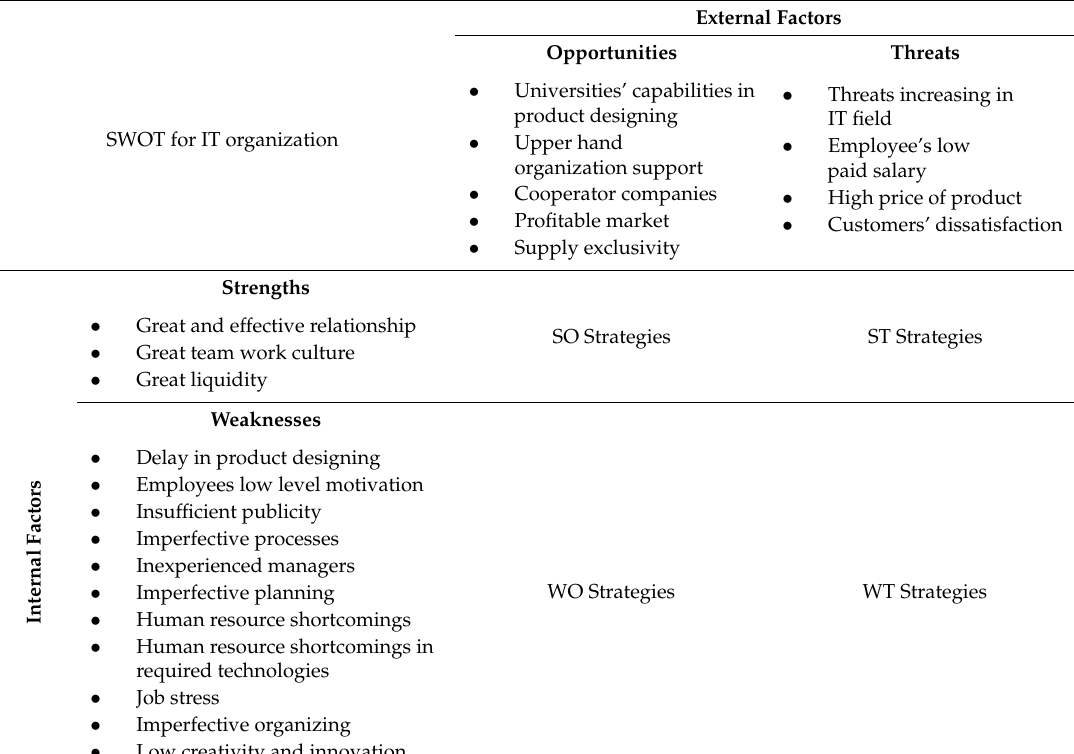
Table 3. Strengths, Weaknesses, Opportunities and Threats (SWOT) Matrix of Considered IT